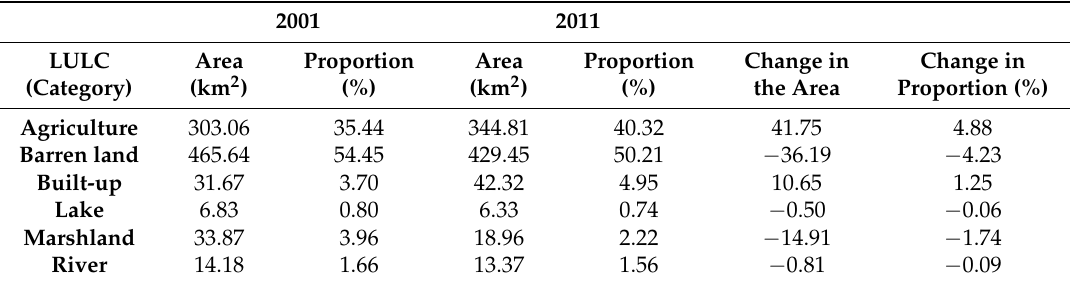
Table 3. Statistical summary for various categories in land use/land cover maps for the years 2001 and 2011.